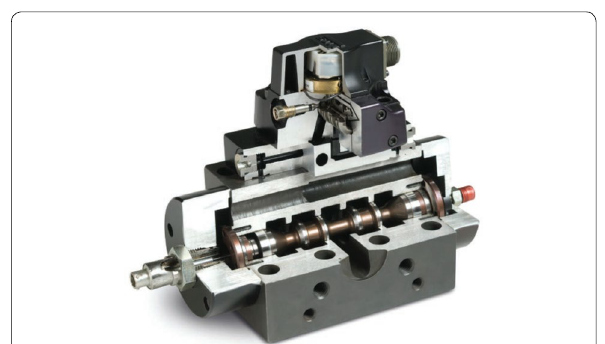
Figure 2 Electro-hydraulic 3-stage